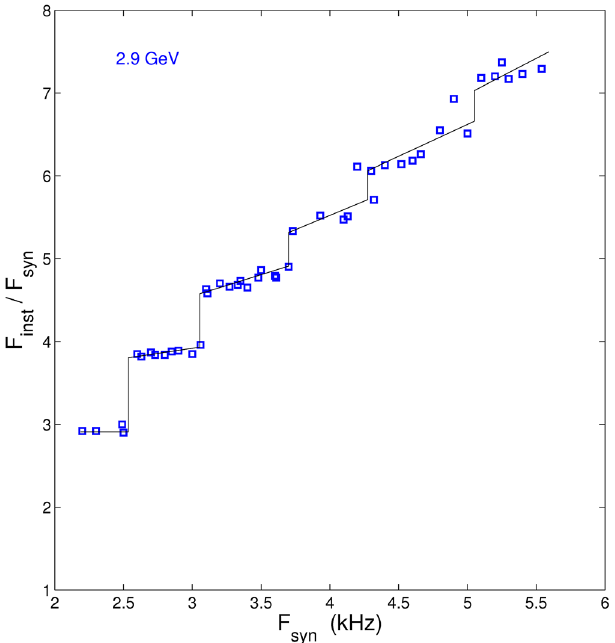
FIG. 8. The 2.9 GeV data of Fig. 6 in expanded scale showing an upward slope across each mode that increases with increasing mode number, in marked contrast to the behavior at 1.5 GeV. The lines through the data are merely a visual